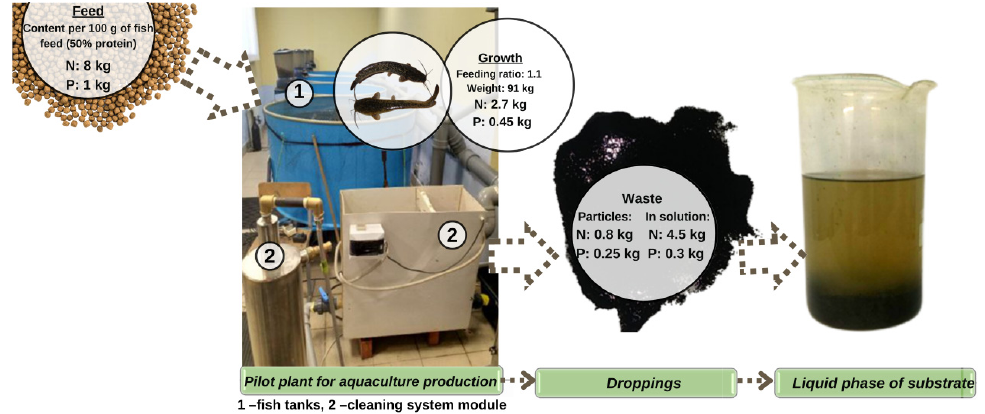
Figure 1. Aquaculture excreta as a substrate.